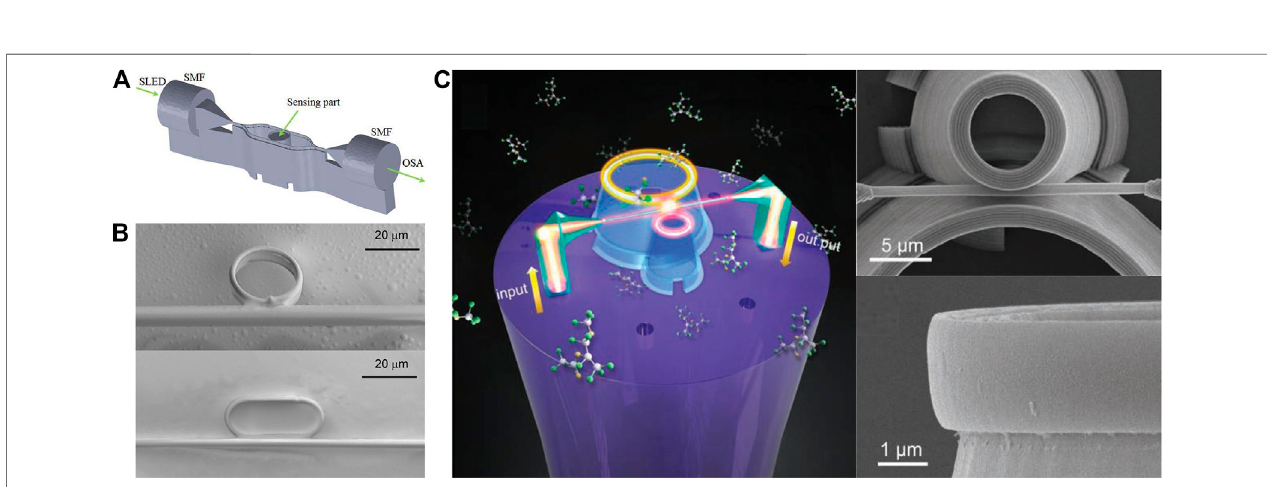
FIGURE 7 | Optical fi ber integrated WGM resonators printed by TPP. (A) Fiber inline polymer WGM resonator for RI sensing (Wei and Krishnaswamy, 2016). (B) Fiber surface integrated polymer WGM resonators for high sensitivity temperature measurement (Li et al., 2019). (C) Polymer WGM resonator with high Q-factor based on SCF end face for vapor sensing (Zhang et al.,